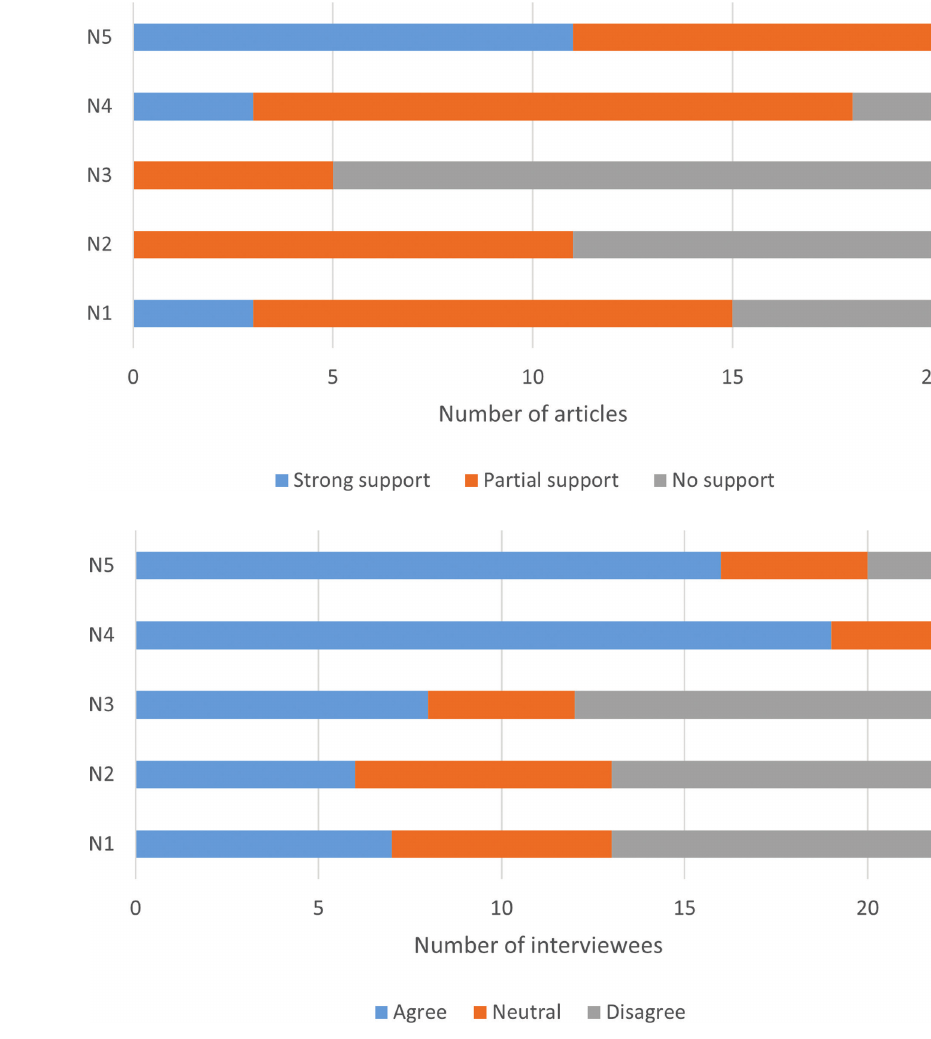
Interview responses on the validity of each narrative. n = 22 as three interviewees chose not to answer these closed ended questions in the